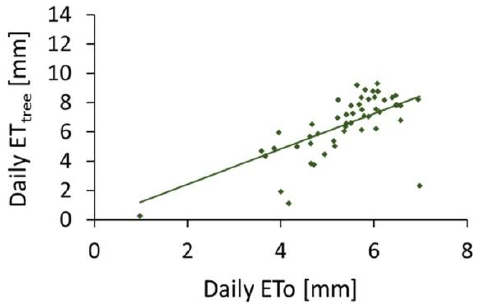
Figure 12. Daily ETo versus tree water consumption (ET trees ) of a multiple row poplar tree wind break. For the formula of this trend line, see Equation (6).